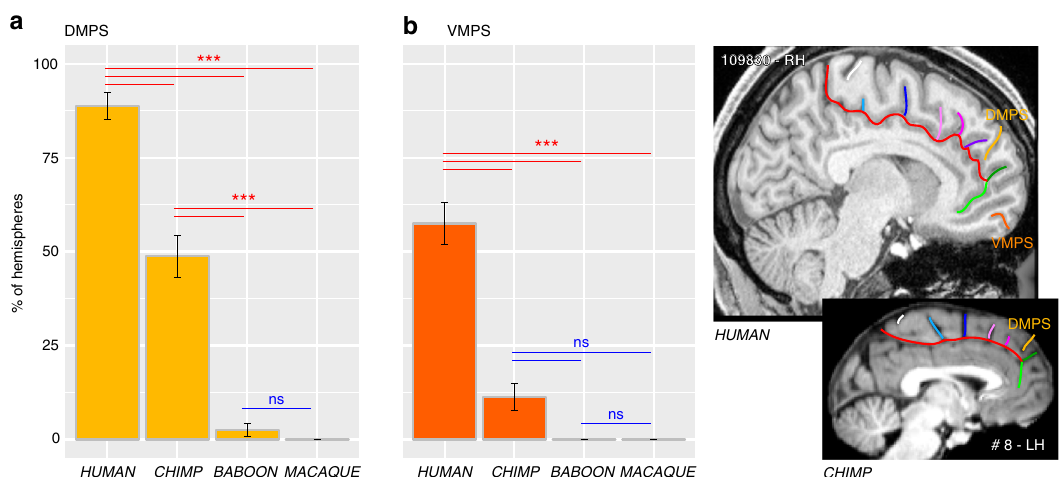
Fig. 7 Probability of occurrence of DMPS and VMPS across primates. The location of the DMPS and VMPS sulci are displayed in human and chimpanzee brains in the right panels. The probability of occurrence of both DMPS ( a ) and VMPS ( b ) is higher in human than in chimpanzee but is very low in